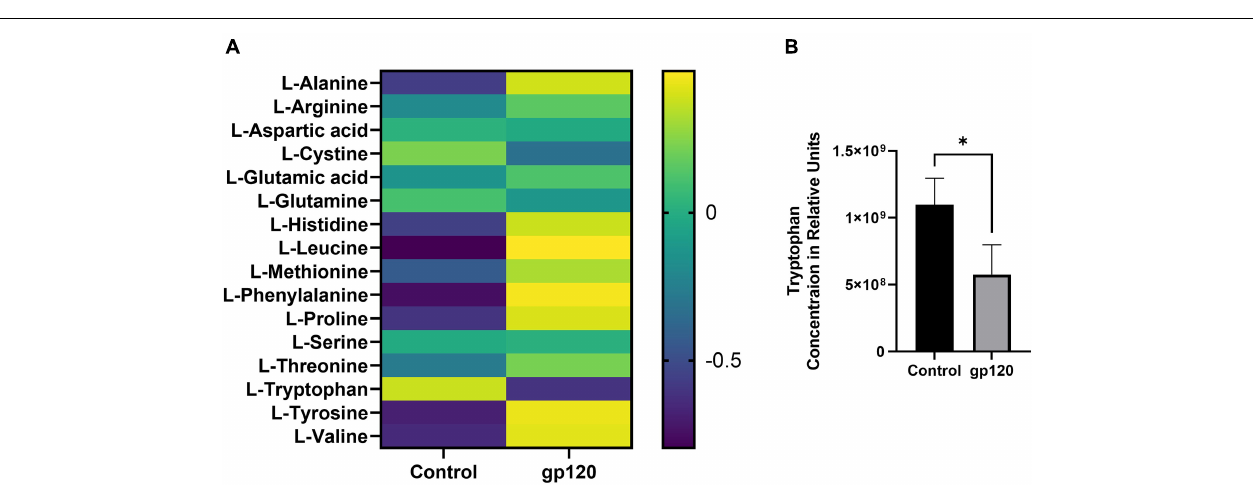
FIGURE 5 | Alterations in amino acids after gp120 treatment. (A) Differential expression of amino acids measured in untreated and gp120-treated LUHMES cells in triplicate by metabolomic analysis. (B) Graph showing a decrease in tryptophan levels in control and gp120 treated LUHMES ( ∗ p < 0.05).